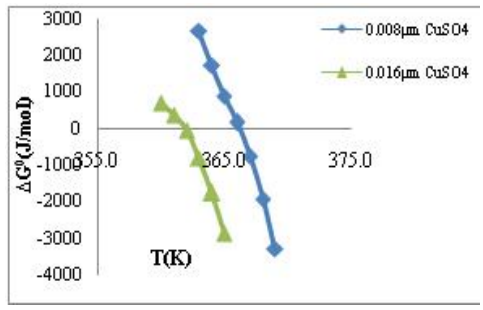
Fig. 3 . The effect of Cu 2+ on ∆ G 0 D at different temperatures at pH=7.4